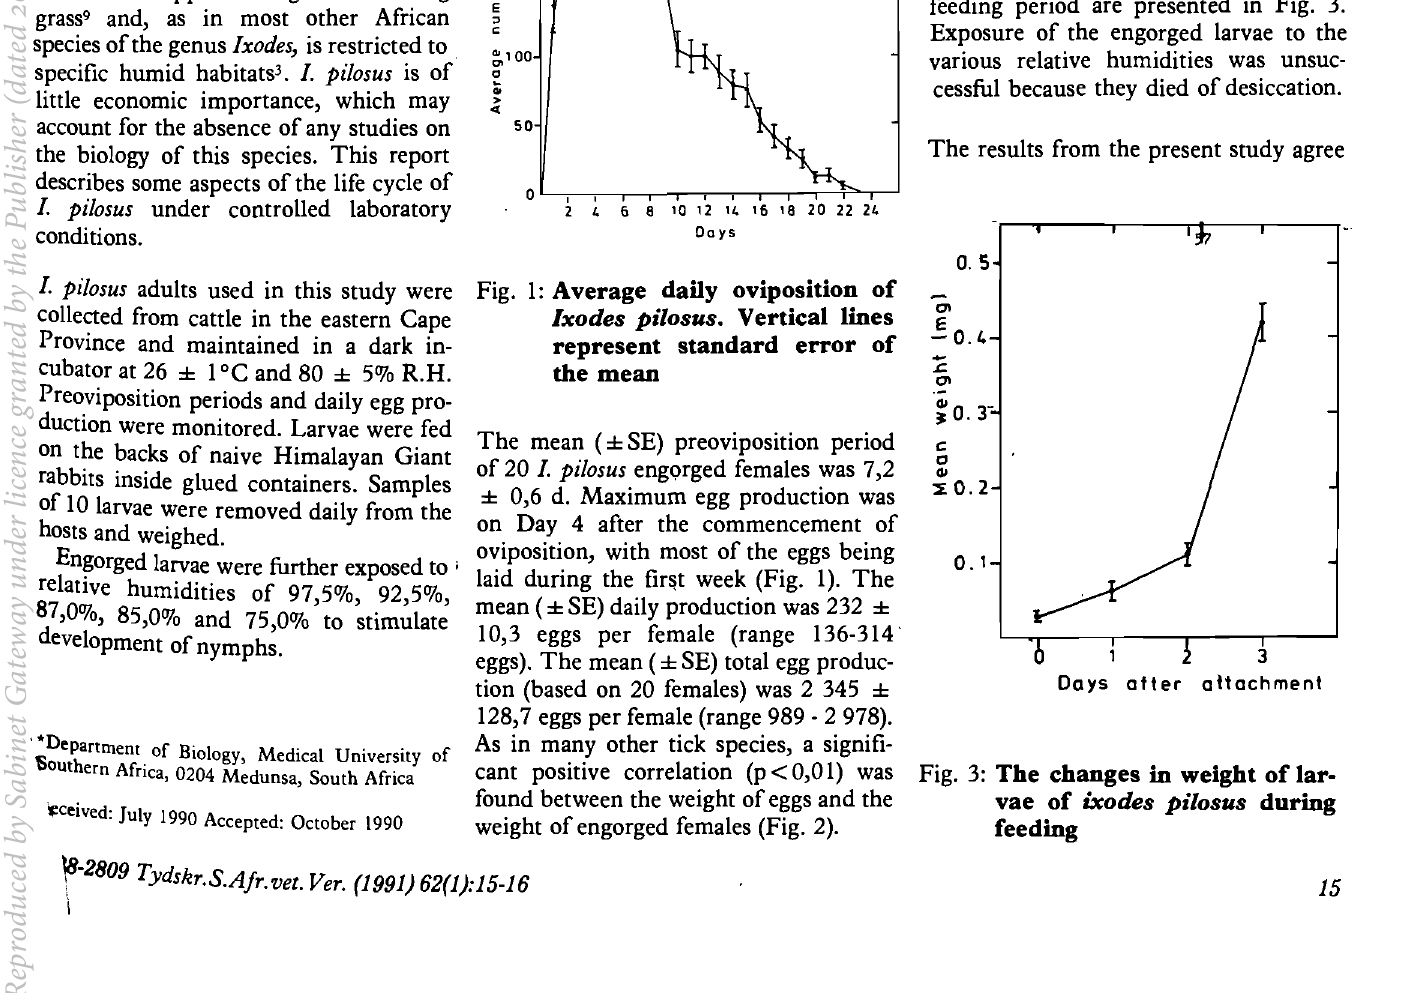
Fig. 2: Relationship between weight of eggs laid and weight of en gorged females of Ixodes pilo sus The mean (± SE) incubation period of the eggs was 30,2 ± 3,7 d. The mean ( ± SE) feeding period of the larvae was 3,3 ± 0, I d. Weight changes during the feeding period are presented in Fig. 3. Exposure of the engorged larvae to the various relative humidities was unsuc cessful because they died of desiccation .